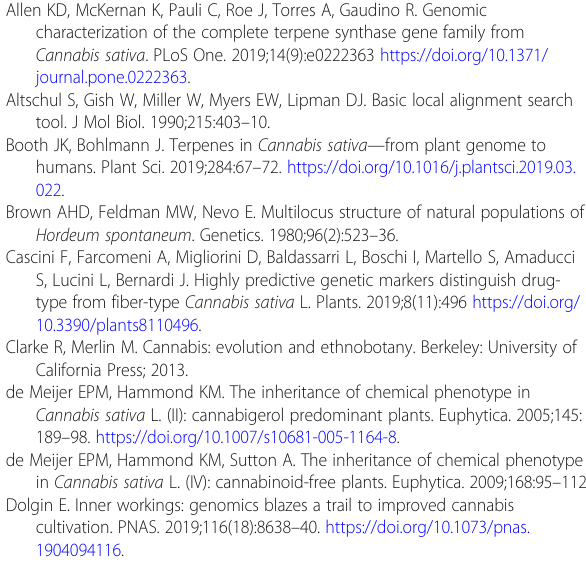
Additional file 1 : Supplementary Figure S1. Locus specific deviation from Hardy-Weinberg Equilibrium (HWE) for each samples seed stock. Heat map indicated P -value of test with pink boxes indication significant deviation from HWE. Supplementary Figure S2. Locus specific devi- ation from Hardy-Weinberg Equilibrium (HWE) for each inferred clusters. Heat map indicated P-value of test with pink boxes indication significant deviation from HWE. Supplementary Table S1. Seed stock specific population genetic metrics. Supplementary Table S2. Locus specific statistics. Supplementary Table S3 . Table indicating the origin of each sample analysed in the